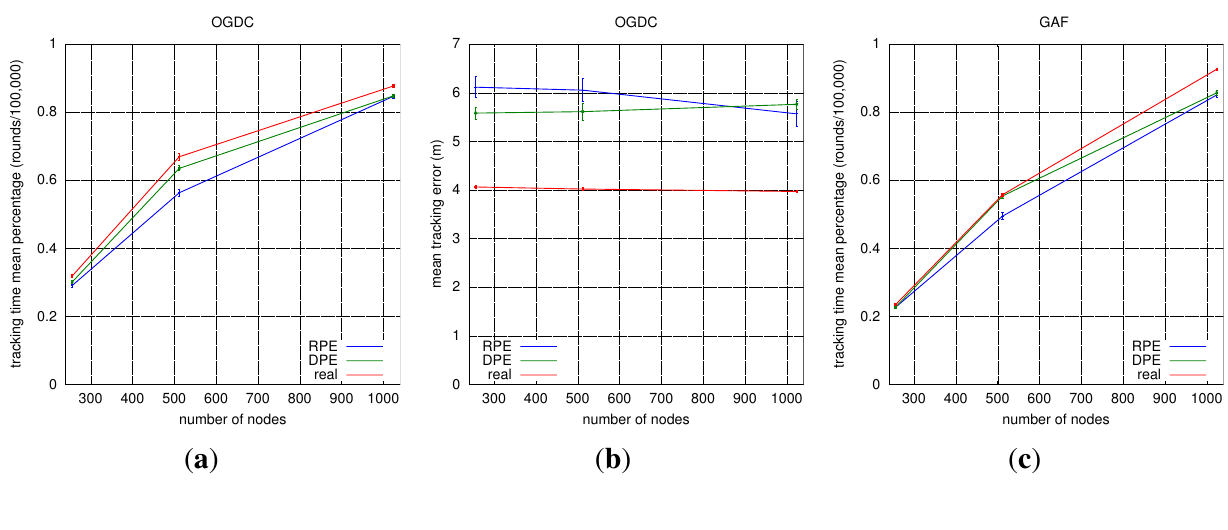
Figure 11. Choosing the Localization Algorithm. ( a ) Mean Tracking Time (OGDC); ( b ) Mean Tracking Error (OGDC); ( c ) Mean Tracking Time (GAF); ( d ) Mean Tracking Error (GAF); ( e ) Mean Tracking Time (A3); ( f ) Mean Tracking Error